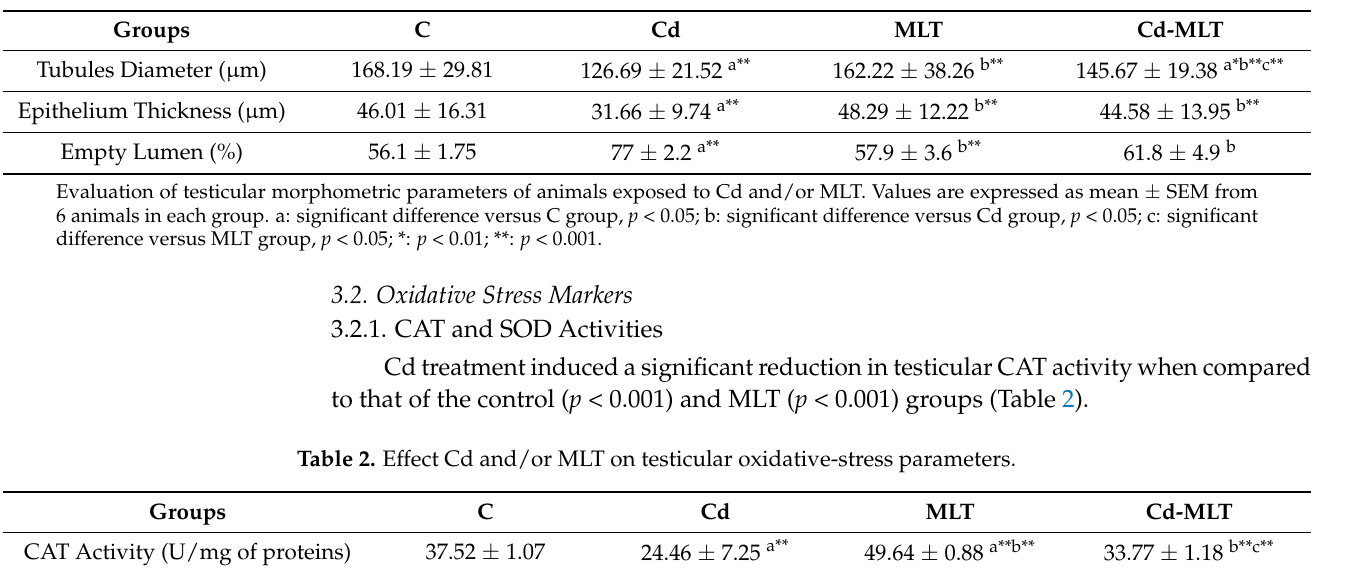
Figure 1. Hematoxylin-eosin staining of C-, Cd-, and/or MLT-treated rat testis. Evaluation of testicular histology of animals exposed to Cd and/or MLT. Rhombus: tubules lumen; Thick arrow: GC desquamation; Triangle: space between GC; Thin arrow: mononuclear cell infiltration; H: hemorrhage. Scale bars represent 40 µm. Table 1. Effect of Cd and/or MLT on testicular morphometric parameters.